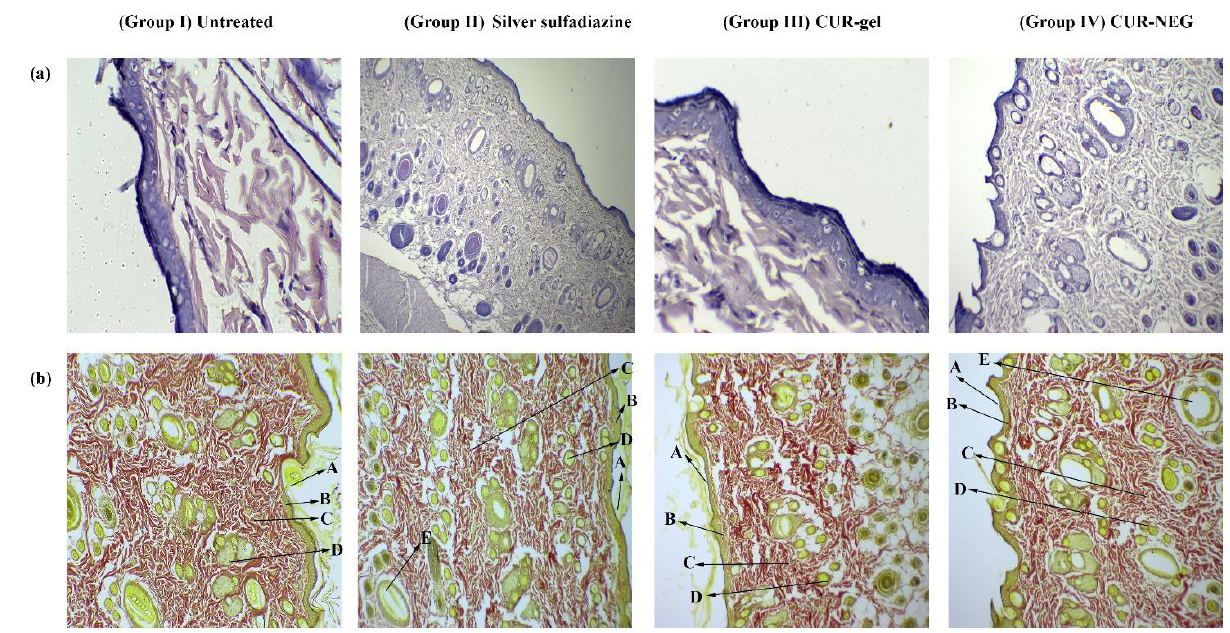
Figure 5. Histopathology analysis of newly healed tissue at day 20. ( a ) Stained with hematoxylin-eosin; ( b ) stained with vangeison to observe collagen formation (at 10 × magnification). A—stratum corneum; B—papillary dermis; C—collagen fibers; D—sebaceous gland; E—hair follicles.